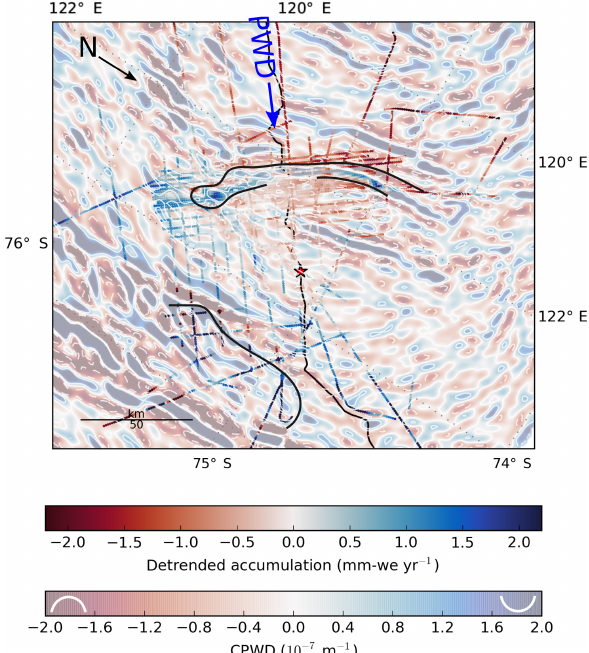
Figure 5. Historical average accumulation rates a 100yrs along the radar lines superimposed on ECMWF ERA40 estimated present- day surface accumulation rates (see Sect. 3.3). There is a very good agreement in the magnitude of accumulation values between the two datasets and in their north–south accumulation gradient on large-scales (100skm), with accumulation decreasing with distance from the coast. White lines outline the same areas of small-scale high accumulation as in Fig. 3. Background is the same as in Fig. 1.